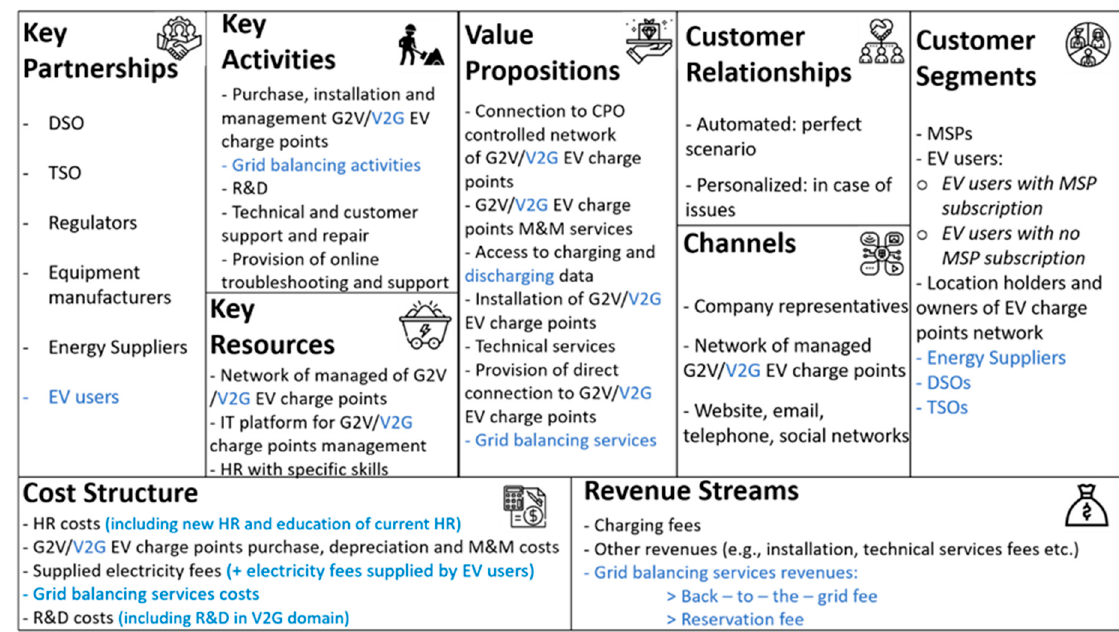
Figure 1. Business model: CPO + V2G (V2G—caused changes are marked in blue) [9].